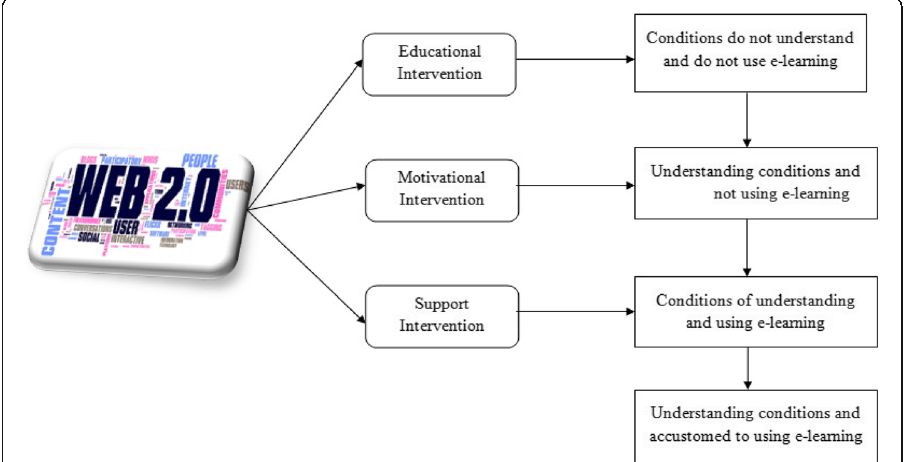
Fig. 6 Behavior Enviroment and the Conducted